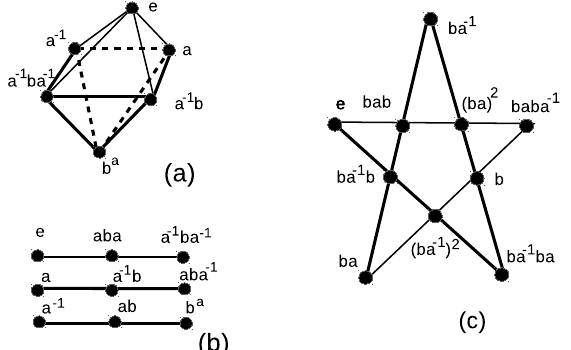
Figure 7. Contextual geometries associated to (i) true and (ii) false for the MICs of the trefoil knot 3 1 listed in Table 2. ( a ) The octahedron, related to the subgroup Γ 0 ( 4 ) of Γ at index 6; ( b ) three disjoint lines K 3 at index 9; ( c ) and the Mermin’s pentagram at index 10. The bold lines are for cosets that are not all mutually